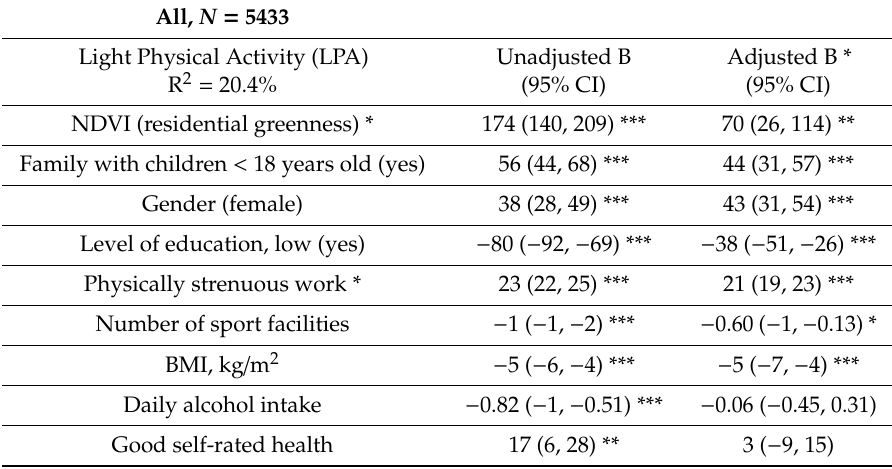
Table A1. Factors associated with accelerometry measured LPA, MPA, VPA / VVPA, and MVPA (daily average MET-minutes) among 46 years old participants according to multivariable linear